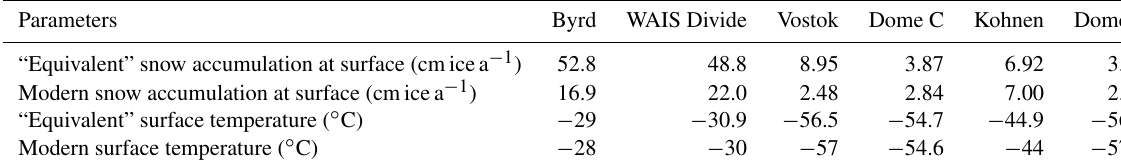
Table 5. Equivalent thermophysical parameters used by the GA in comparison with published data. Parameters